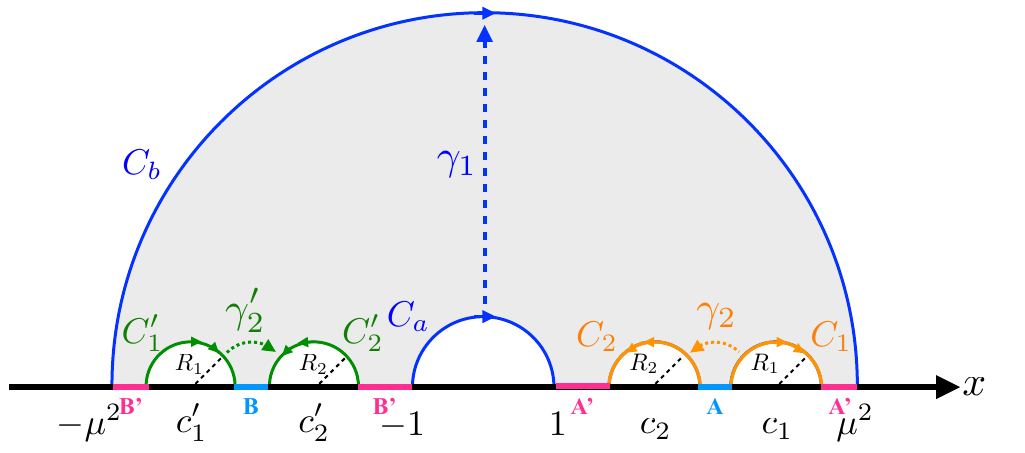
Figure 4 . Four boundary wormhole of our interest. Here we assign the boundary subregions A = [ c 2 + R 2 , c 1 − R 1 ] , B = [ c 0